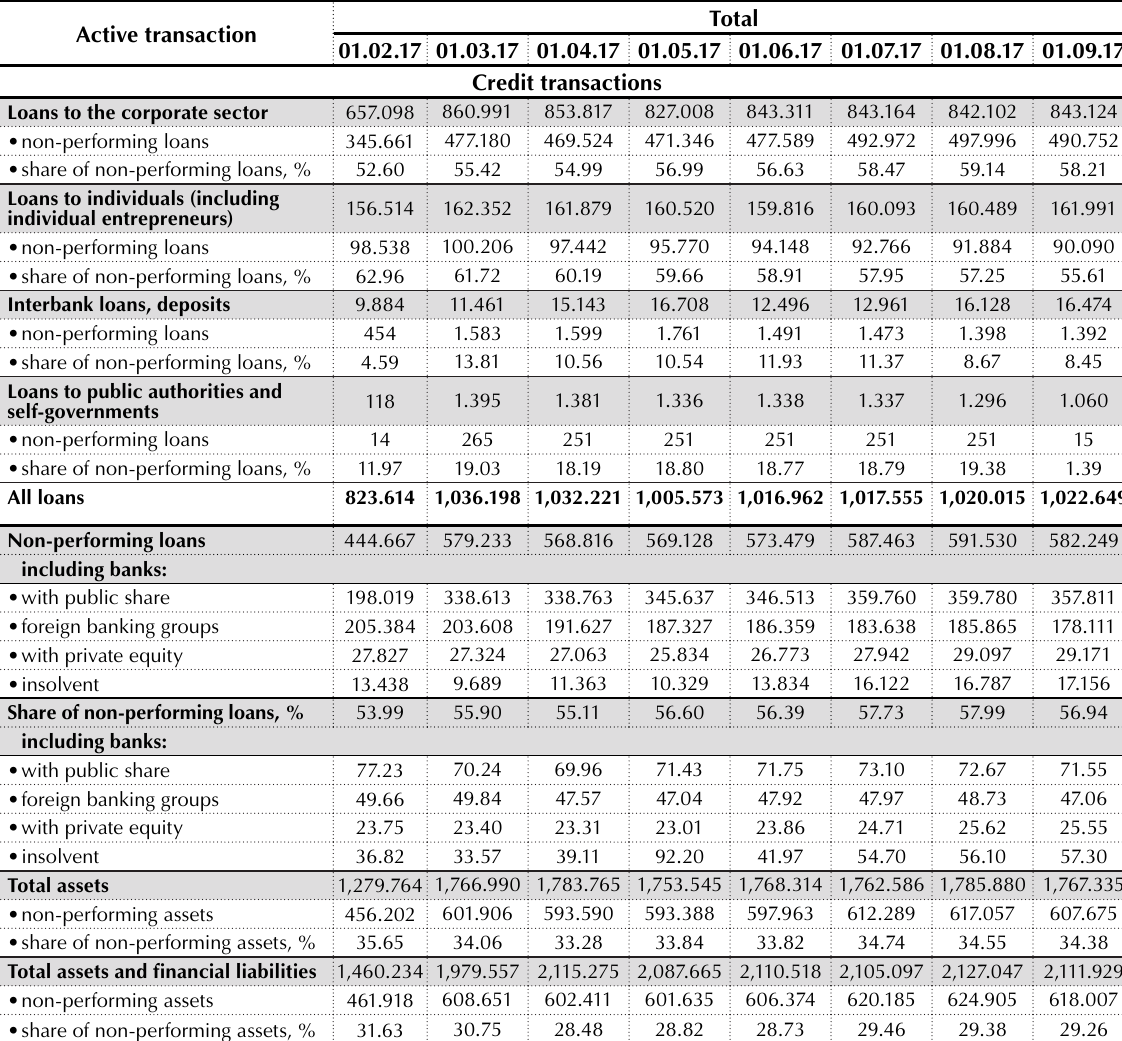
Table 1. Volumes of active transactions and share of non-performing